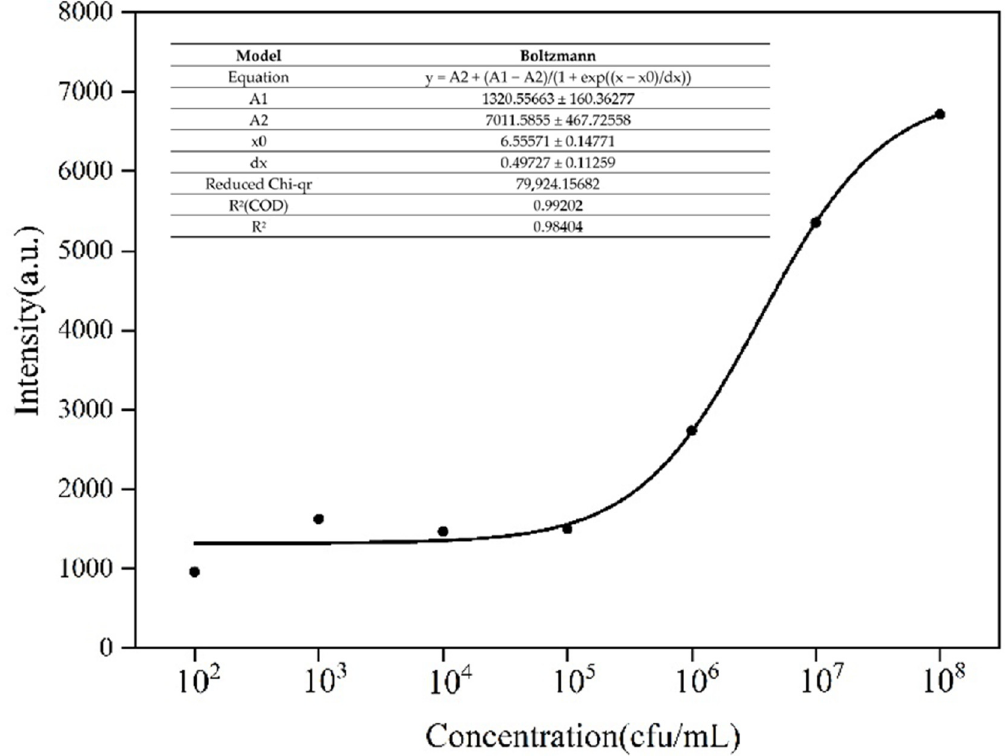
Figure 8. FittinganalysisofSERStestresultsofdifferentconcentrationsof Aspergillusflavus Figure 8. Fitting analysis of SERS test results of different concentrations of Aspergillus flavus spore Suspension.